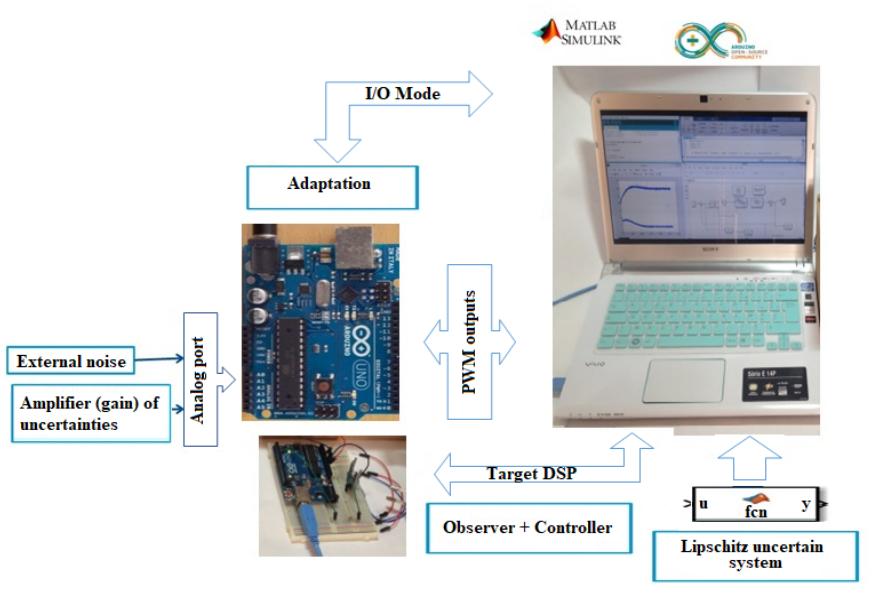
Figure 1. Block diagram of real-time